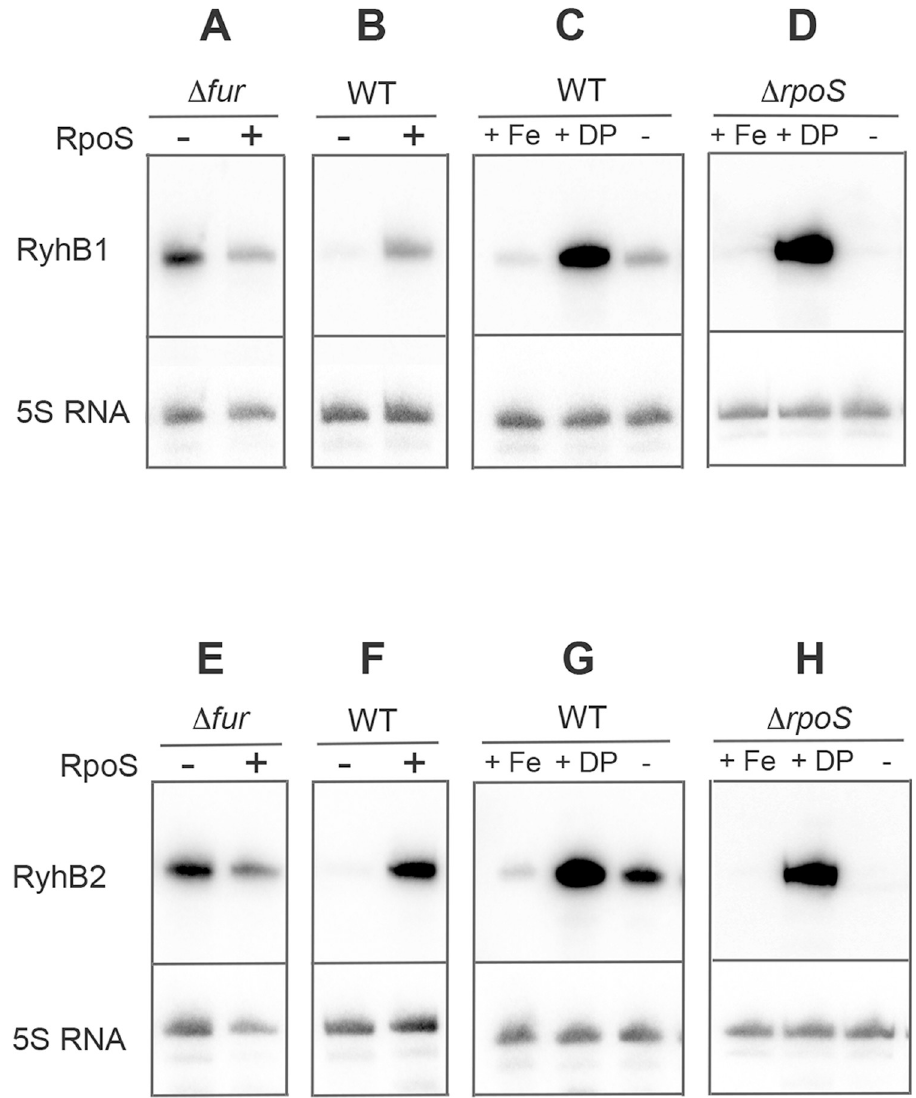
Fig 1. Regulation of ryhB1 and ryhB2 by σ S in Salmonella . The RyhB1 and RyhB2 sRNAs (of 96 and 98 nucleotides, respectively) were detected in Northern experiments as previously reported [5]. Blots were stripped and re-probed with 5S RNA probe to confirm loading of equal quantities of total RNA of the strains grown to stationary phase for 18 h at 37˚C. (A, E) Effect of the Δ rpoS mutation on ryhB1 and ryhB2 expression was assessed in a Δ fur genetic background. (B, F) Control experiments showing the negative effect of the Δ rpoS mutation on ryhB1 and ryhB2 expression [5]. (C, D, G, H) Detection of the sRNAs in the wild-type and Δ rpoS strains grown in LB supplemented or not with FeCl 2 100 μ M and 2,2’-dipyridyl (DP) 100 μ M. Relative quantification of bands intensity (normalized to the 5S RNA) indicated that the Δ rpoS mutation decreased by about ten-fold the amounts of RyhB1 and RyhB2 detected in the wild-type strain, as previously reported [5]. In contrast, in the Δ fur background, the Δ rpoS mutation had no major impact on the amount of RyhB2 and increased the amount of RyhB1 by about three-fold. Blocking Fur-mediated repression by DP increased the expression levels of both sRNAs by more than 10-fold in the Δ rpoS mutant. In the wild- type strain, the impact of DP was stronger on RyhB1 than RyhB2 production (10 and 3.5 -fold, respectively). Fur activity. Altogether, these results were consistent with a model where σ S is required for ryhB1 and ryhB2 transcription under Fur repressing conditions only (Fig 2C). In our global analyses, the Δ rpoS mutation had no effect on the abundance of the fur transcripts [5] and Fur